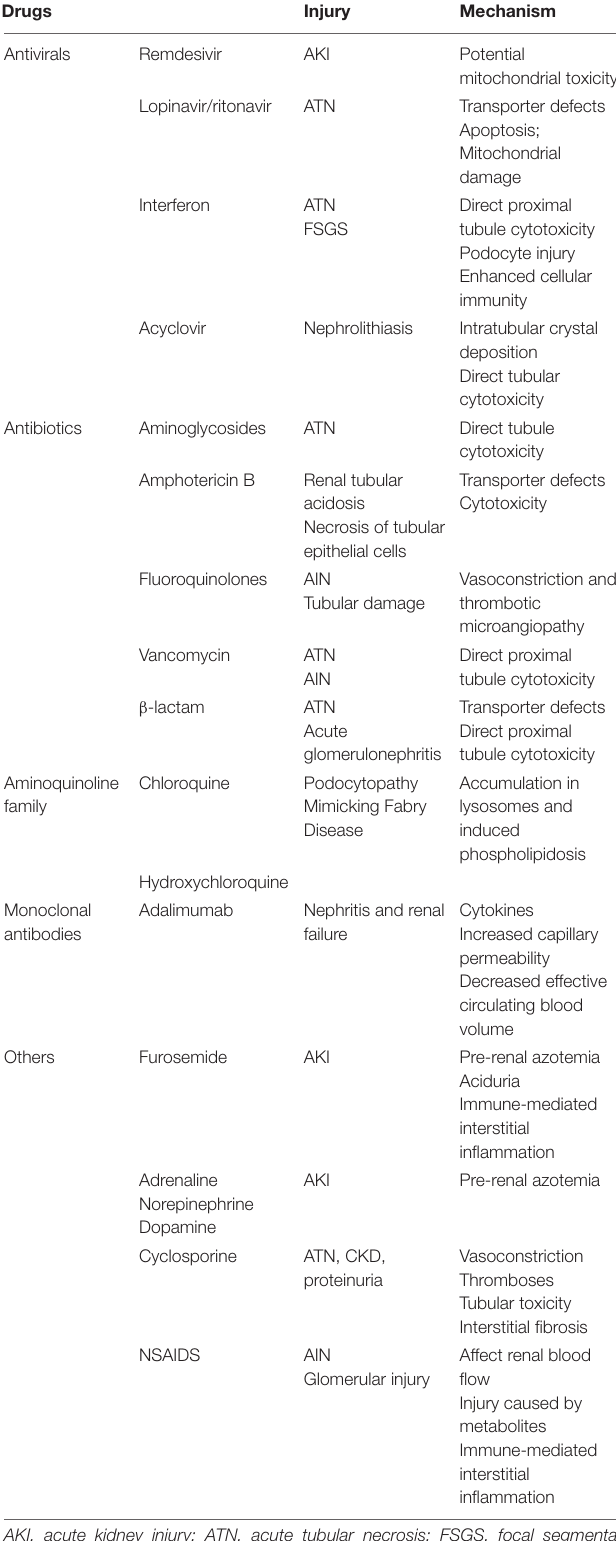
TABLE 1 | Potential AKI causing drugs applied in COVID-19, injury manifestations and related